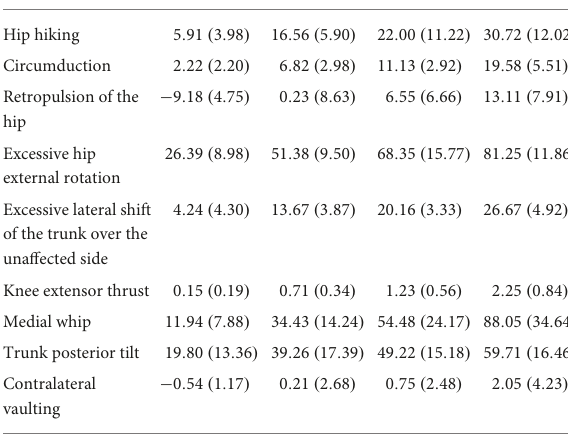
TABLE 4 Spearman’s rank correlation coefficient values between the index values calculated by the gait analysis system in the Welwalk WW-2000 and the marker-based motion capture